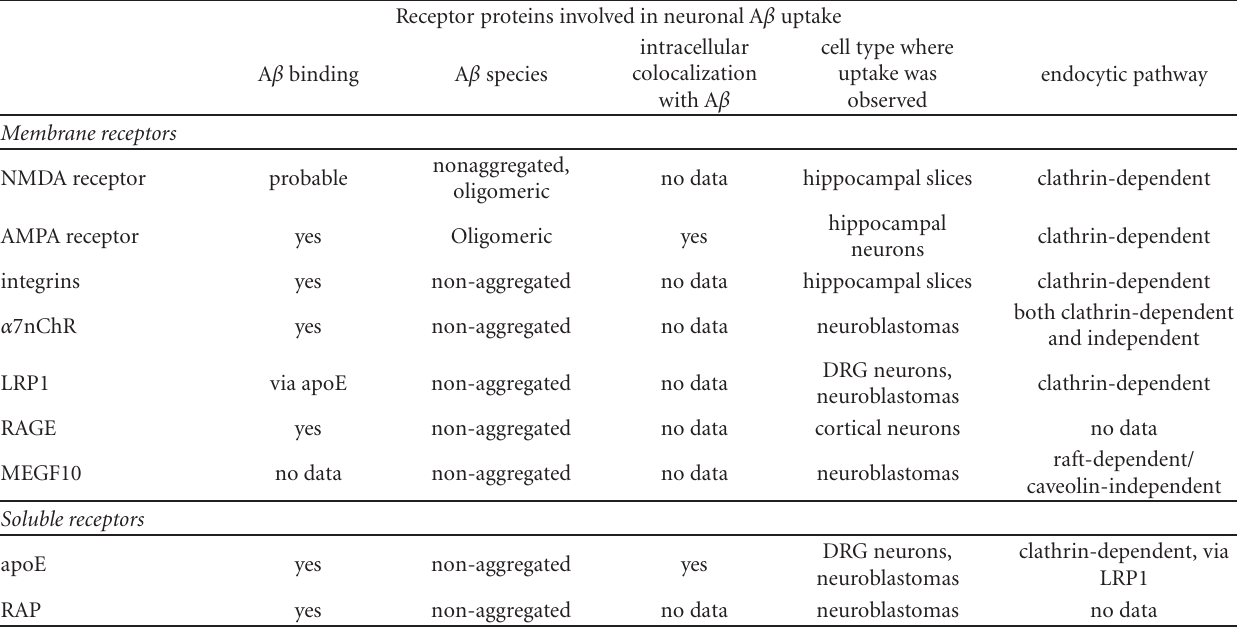
Table 1: Summary of receptor proteins involved in the neuronal uptake of A β